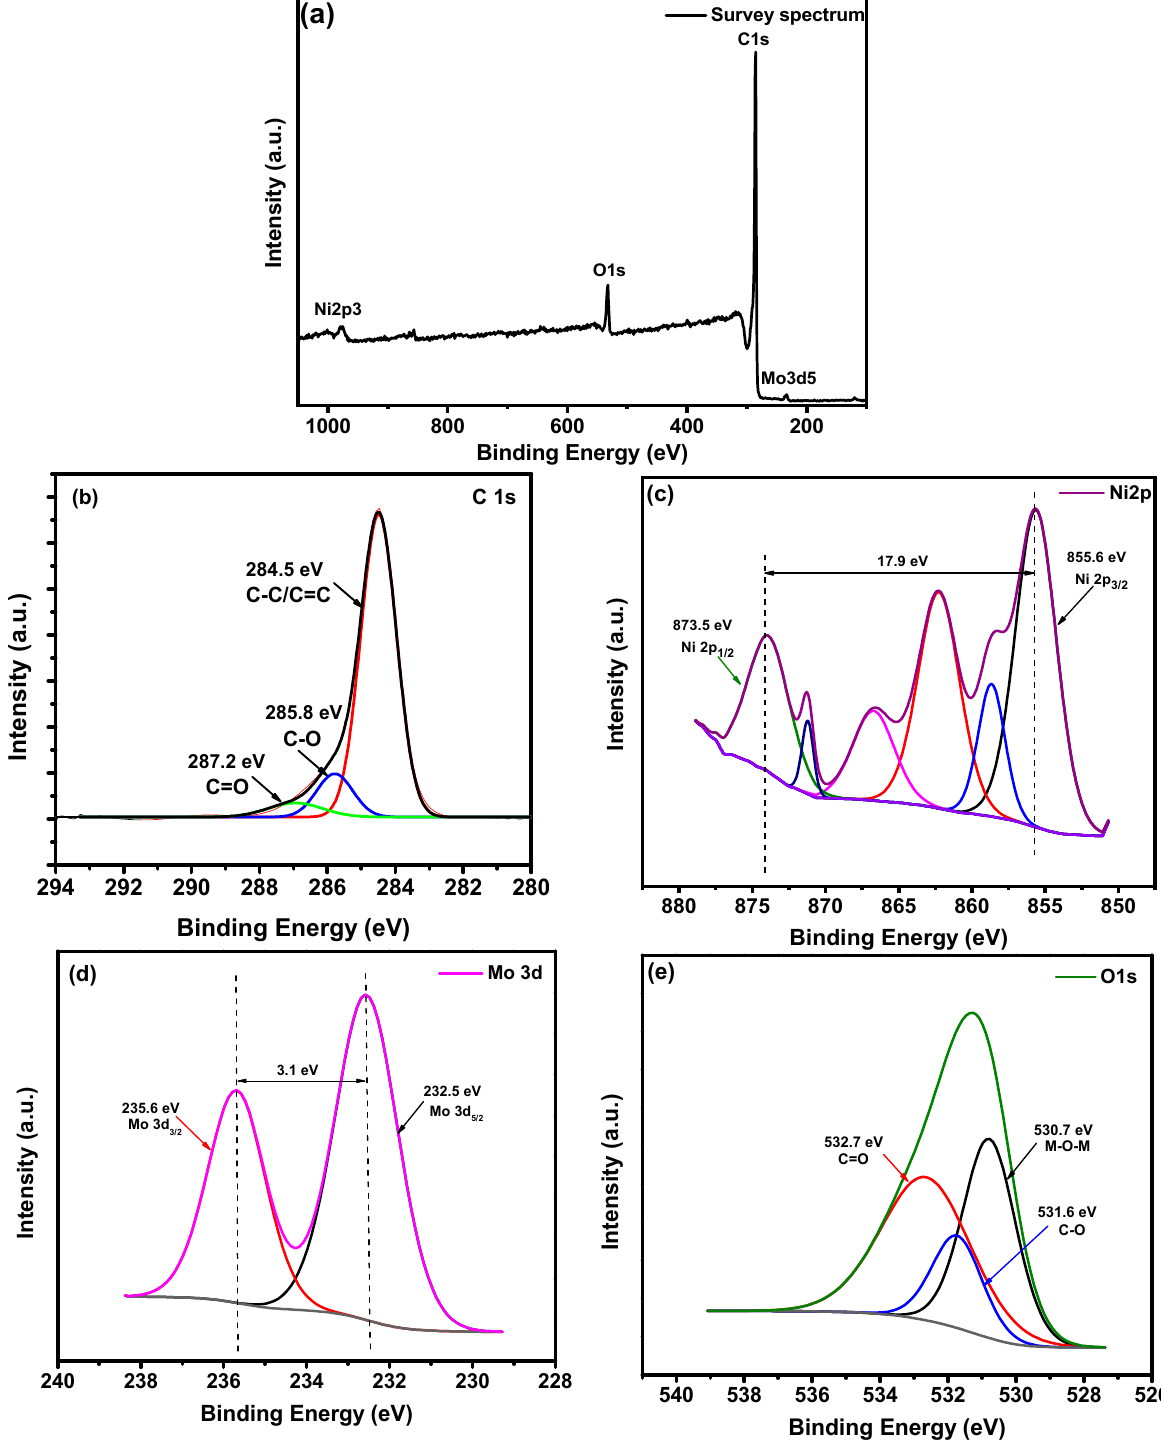
Figure 3. XPS spectra of NiMo1/AC: ( a ) Survey spectrum; ( b – e ) core-level spectra ( b ) C 1s, ( c ) Mo 3d, ( d ) Ni 2p, and ( e ) O 1s.